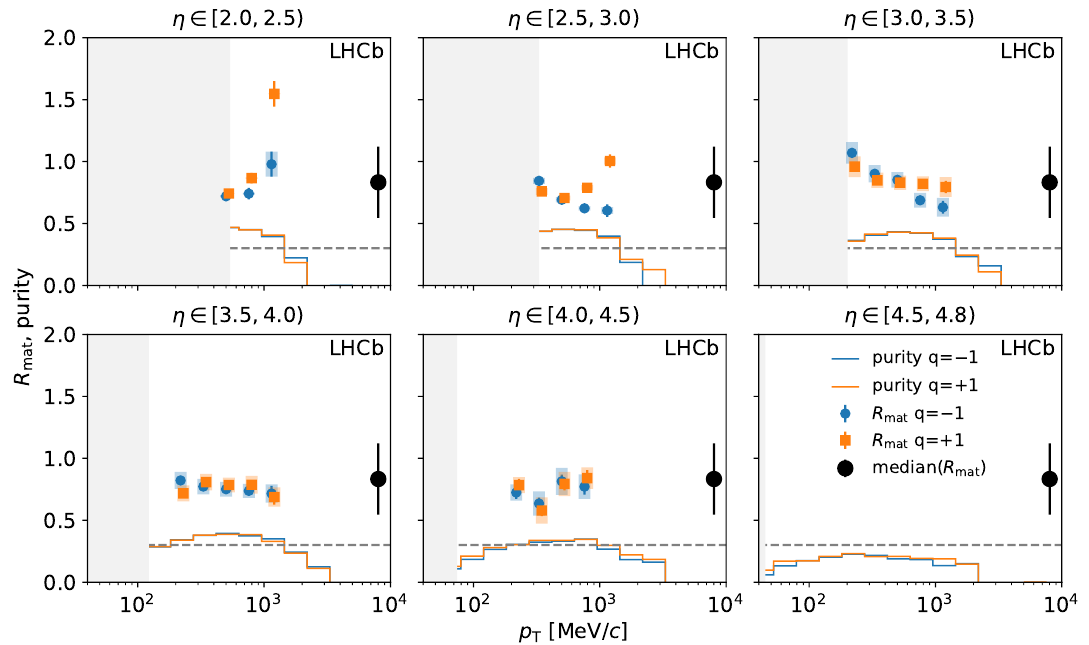
Figure 6 . Ratio of the proxies for material interactions in data and simulation and purity of the proxy in intervals of η and as a function of p T for the LHC fill recorded with the magnetic field pointing upwards and the simulated sample with the same magnetic-field configuration. The quantities are shown separately for positively and negatively charged particles. The error bars indicate the statistical uncertainty, and the boxes indicate the systematic uncertainty. The points are slightly displaced horizontally within the p T intervals to increase the visibility. The dashed grey lines represent the purity threshold. The larger points indicate the median value computed from the intervals above the threshold. The light-grey areas represent the limit of the kinematic